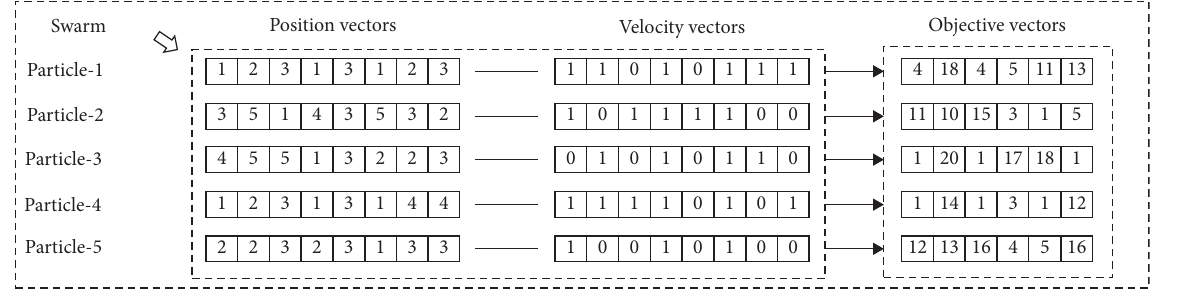
Figure 3: Demonstration of swarm